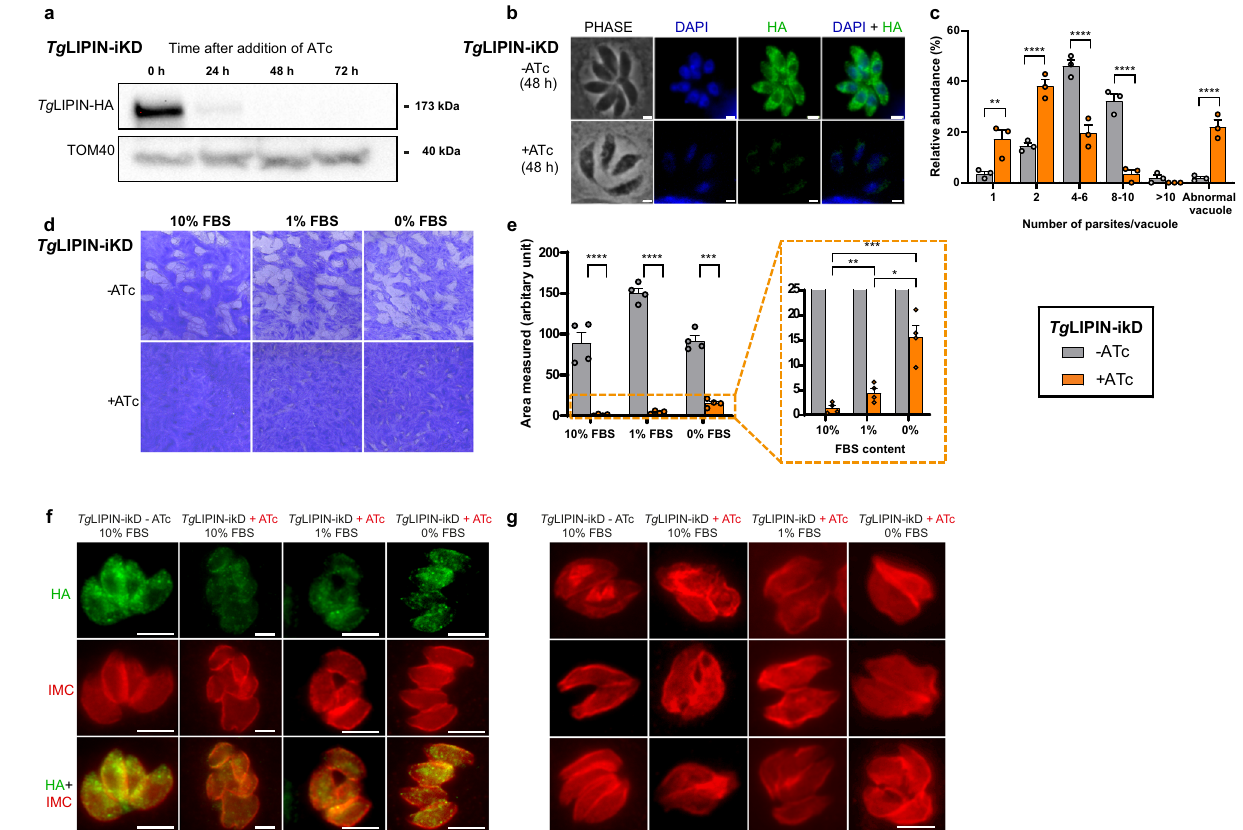
Fig. 2 Tg LIPIN is indispensable for parasite replication and growth within its host. a Western blot shows Tg LIPIN downregulation, 48 h + ATc (0.5 μ g/ mL), Tg LIPIN (anti-HA), and TOM40 (control). b IFA of Tg LIPIN-ikD, indicating loss of protein using anti-HA antibody at 48 h + ATc, Scale bar: 2.0 μ m. c Replication rate of Tg LIPIN parasites grown with ( + ) or without ( − ) ATc measured by parasite number per parasitophorous vacuole after 24 h of growth post infection (>100 vacuoles were counted per biological replicate; n = 3, unpaired t test P values where ** P = 0.002 − ATc vs + ATc 1 parasite/vacuole, **** P < 0.000001 − ATc vs + ATc 2/4-6/8-10 and abnormal parasite/vacuole). Data are presented as mean values + / − SEM. d Tg LIPIN-ikD